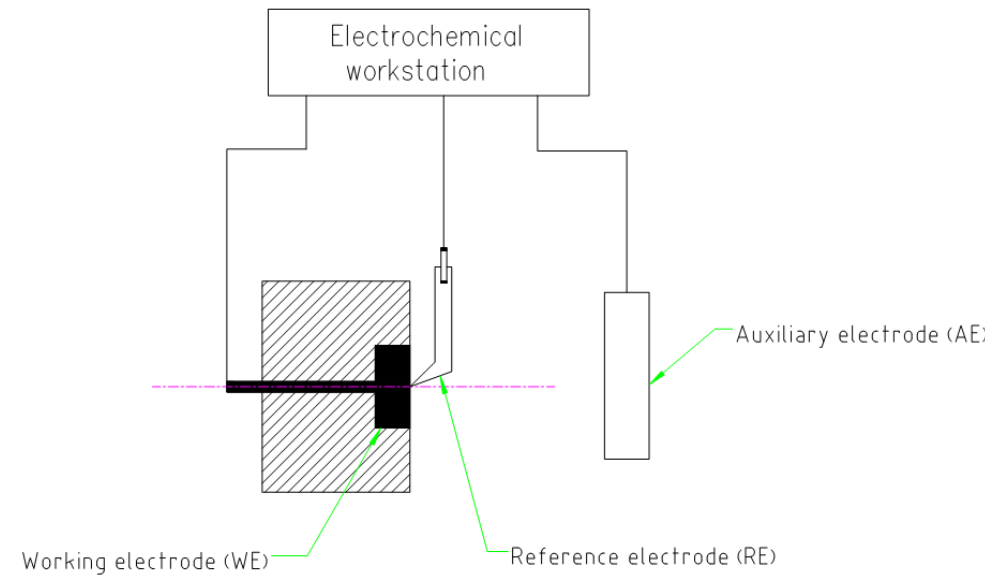
Figure 6. Schematic diagram of electrochemical experiment